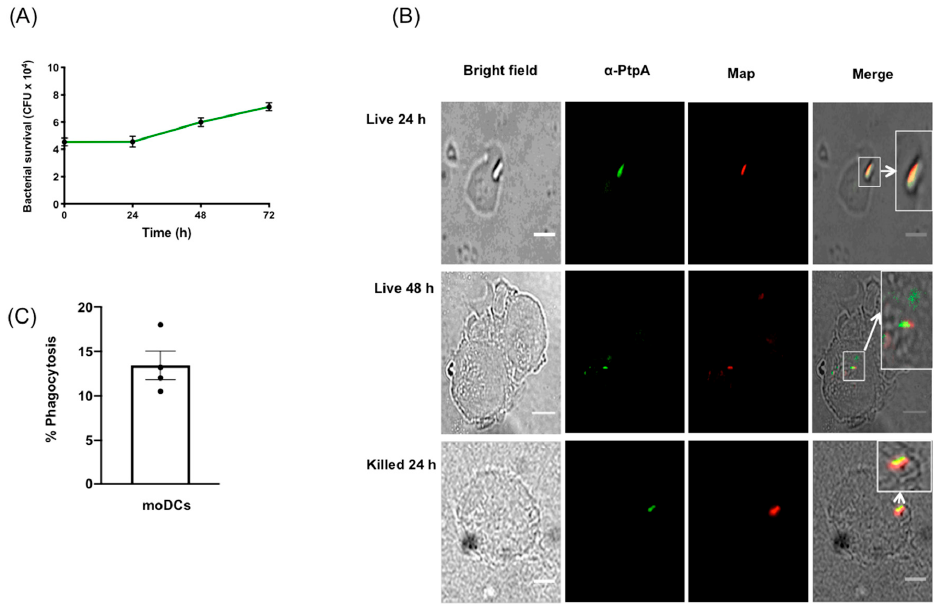
Figure 1. Mycobacterium avium subspecies paratuberculosis (MAP) infects and replicates in human monocyte derived dendritic cells and expresses PtpA. ( A ) Human moDCs were exposed to MAP and harvested at 24 h intervals for 72 h. Cell lysates were plated on MAP culture media and the colony-forming units (CFUs) were counted, after 8 weeks of growth. Error bars are the mean ± SEM of n = 3 DC blood donors analyzed in triplicate. ( B ) moDCs were processed and imaged for the protein phosphatase PtpA (green) and MAP (red), at 24 and 48 h post-exposure to MAP. Images representative of experiments using n = 3 independent DC blood donors. ( C ) Phagocytosis index expressed in percentages of n = 300. Scale bar = 20 μ m